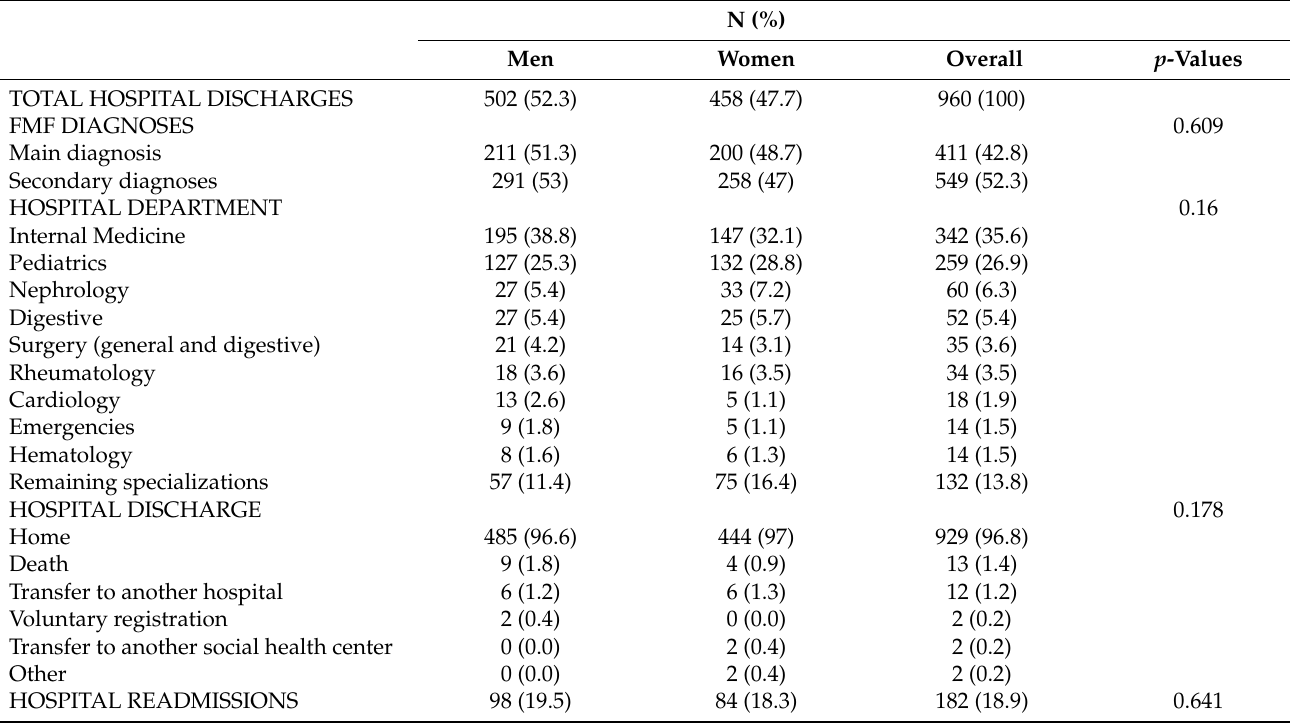
Table 1. Characteristics of FMF-related hospitalizations: 2008–2015.